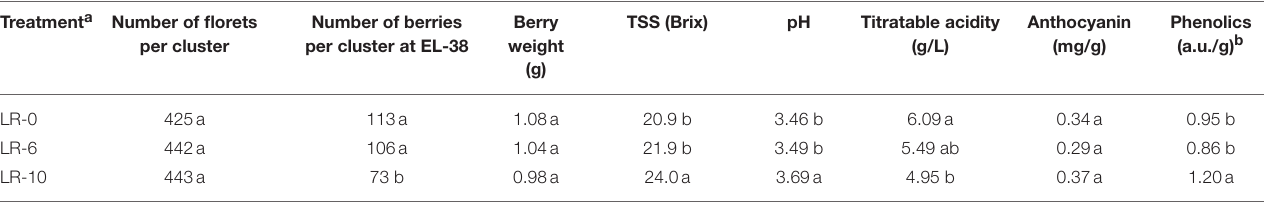
TABLE 2 | Impact of leaf removal on cluster components, basic fruit chemistry, and phenolic content. Treatment a Number of florets per